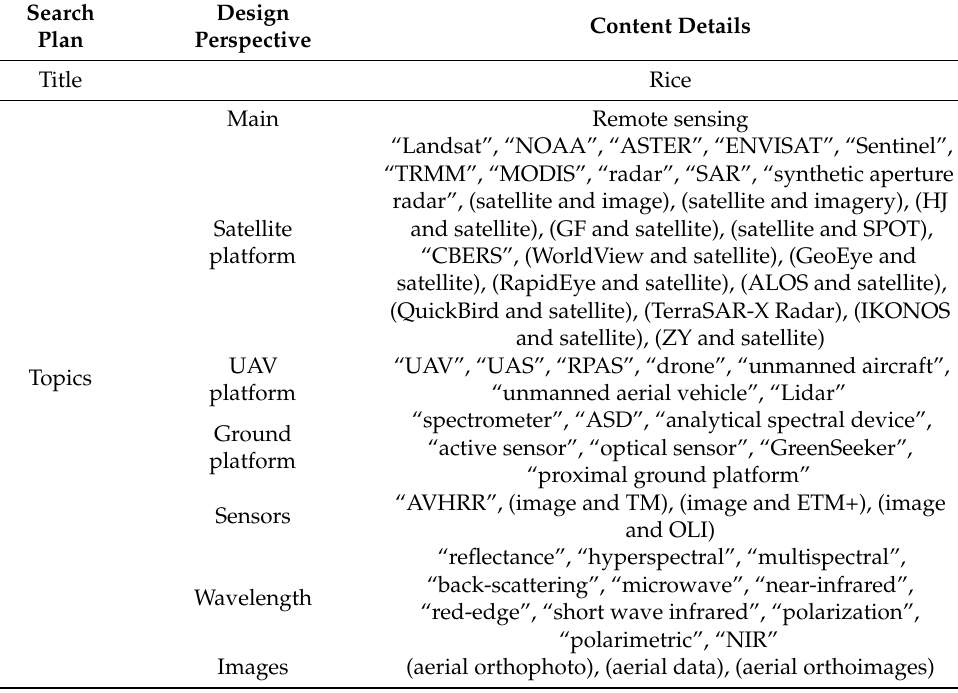
Table 1. Search strategy of the Boolean